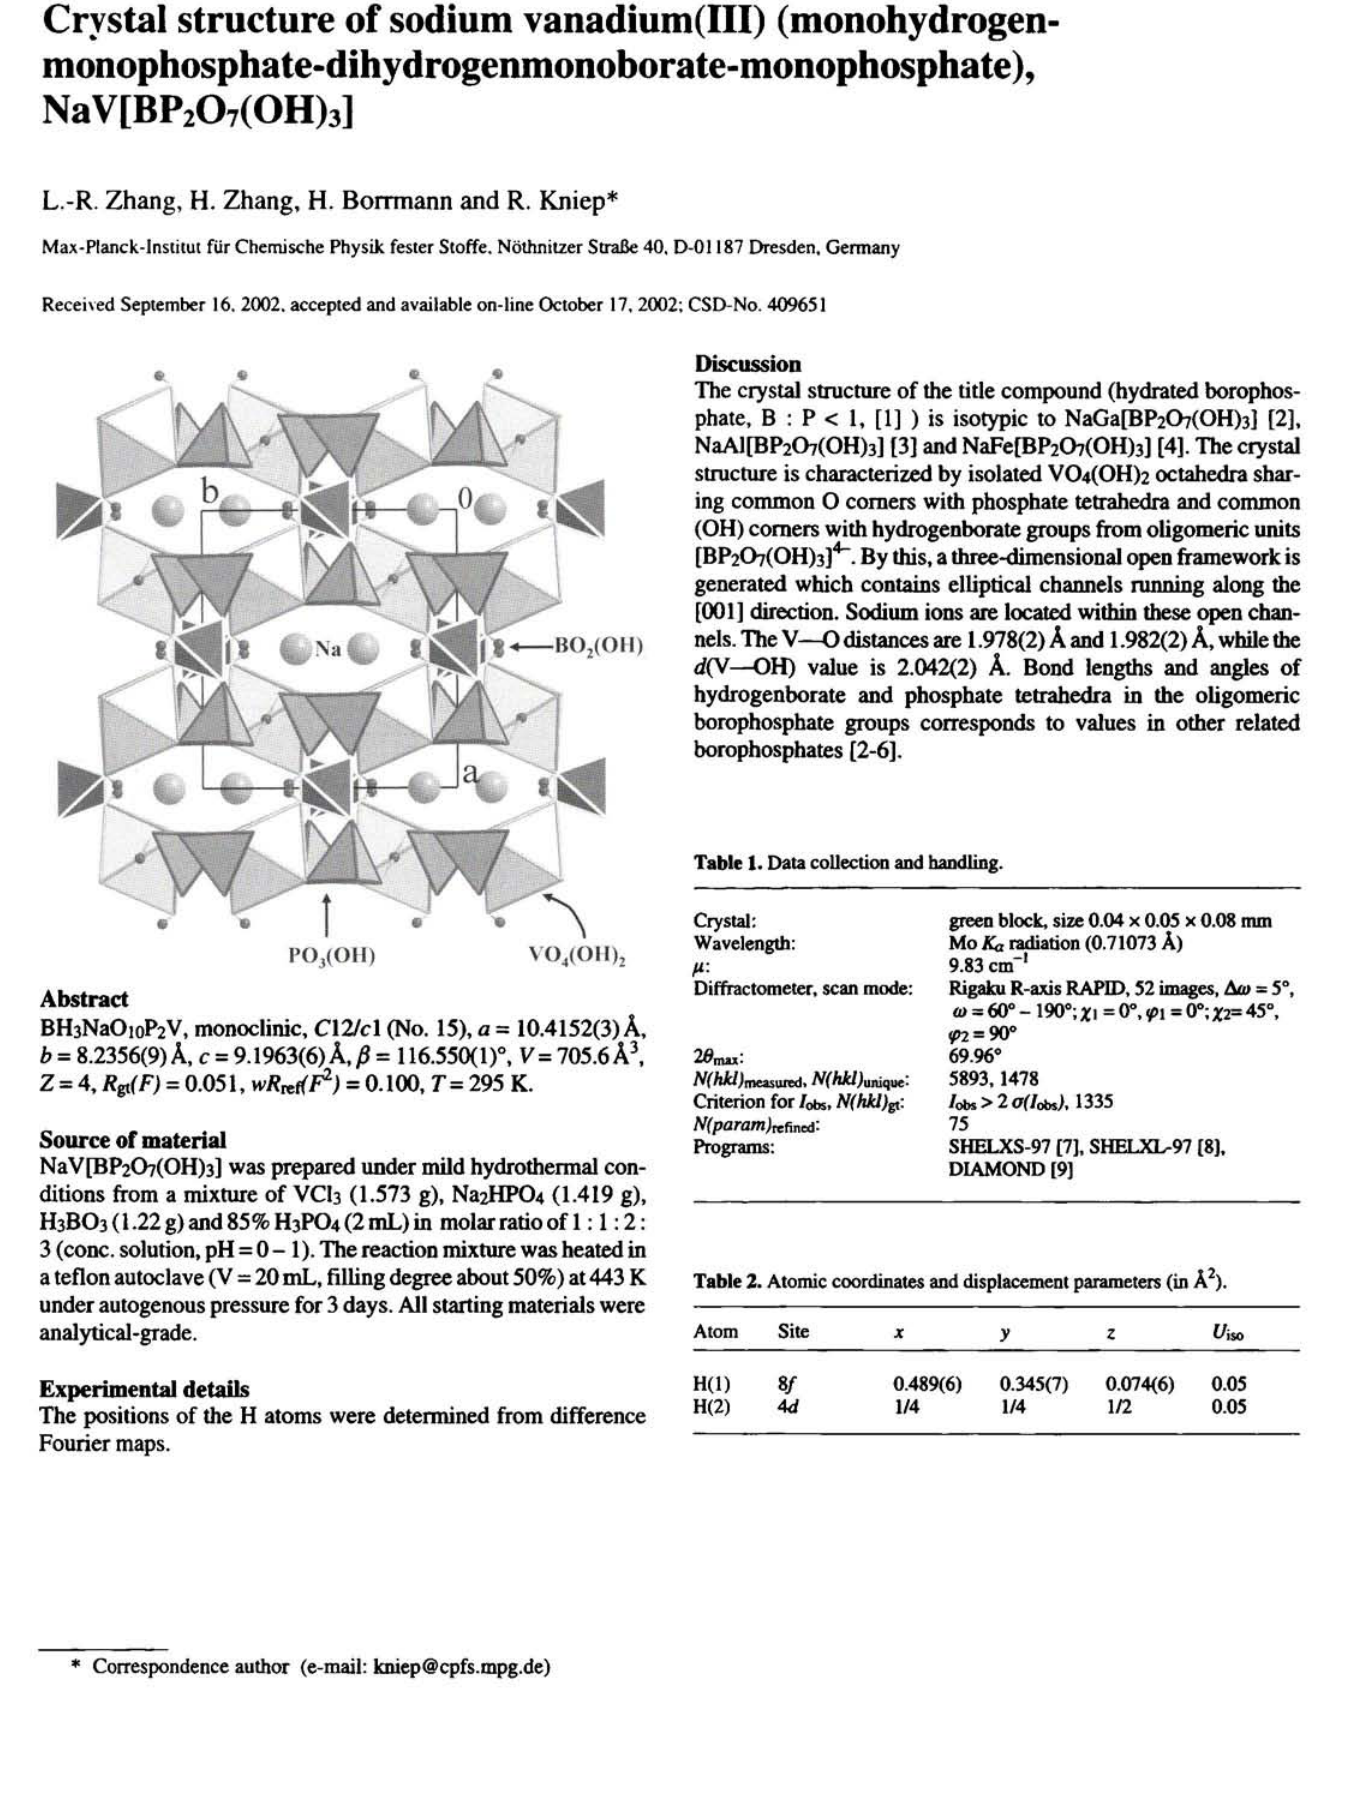
Table 2. Atomic coordinates and displacement parameters (in Â 2